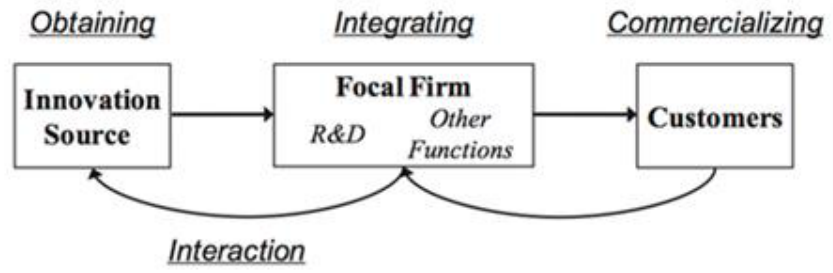
Fig. 1. Integrated four-step model for outside-in open innovation process (West & Bogers,